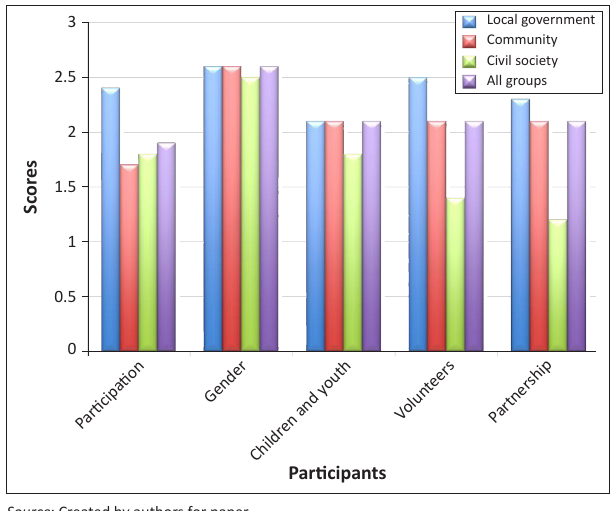
FIGURE 3: Overall mean scores for indicators on inclusion and